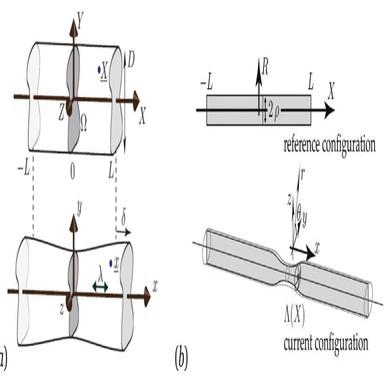
Problem definition and comparison between reference and deformed configuration. X ¼ ðX; Y; ZÞ represents the position of a point belonging to a general cross-section in the reference configuration, x ¼ ðx; y; zÞ represents the position of the same point in the current configuration. (a) Solid having an arbitrary cross-section: D represents the dimension of the cross-section and L the axial portion taken into account. (b) Cylinder with length 2L and radius q .